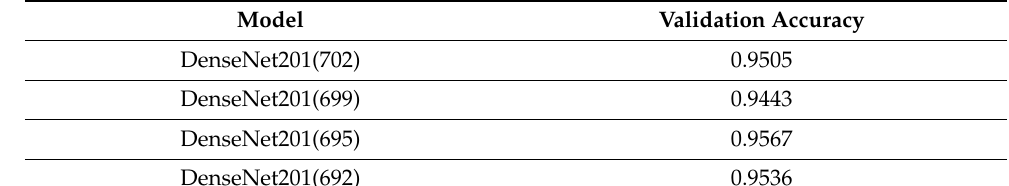
Table 8. DenseNet layers’ accuracy.